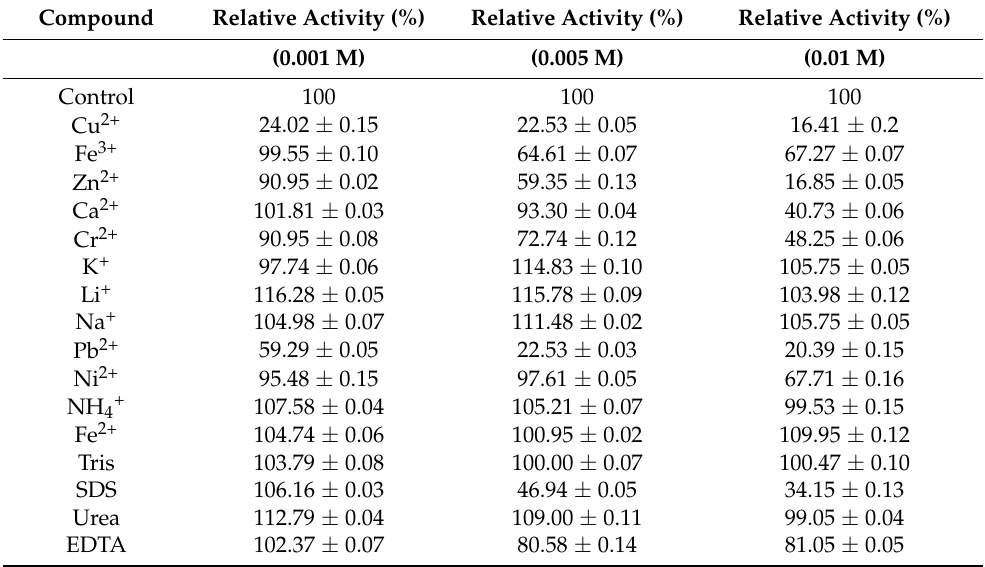
Table 3. Effects of metal ions and compounds on the activity of dextranase.